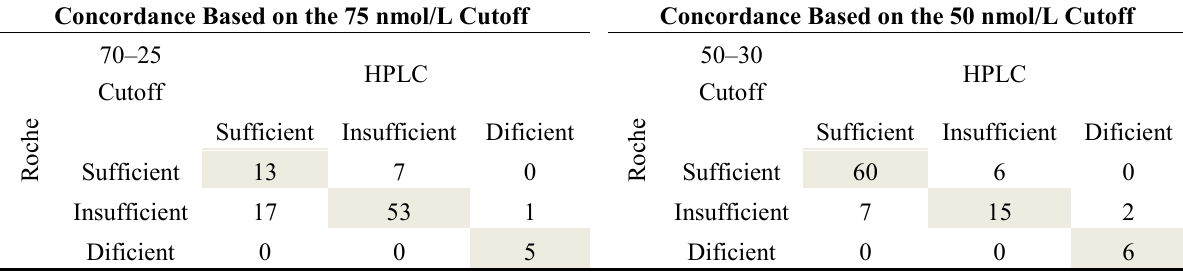
Table 2. Concordance of HPLC and Roche Diagnostics assays to 25 (OH) D based on 2 decision criteria. Concordance Based on the 75 nmol/L Cutoff